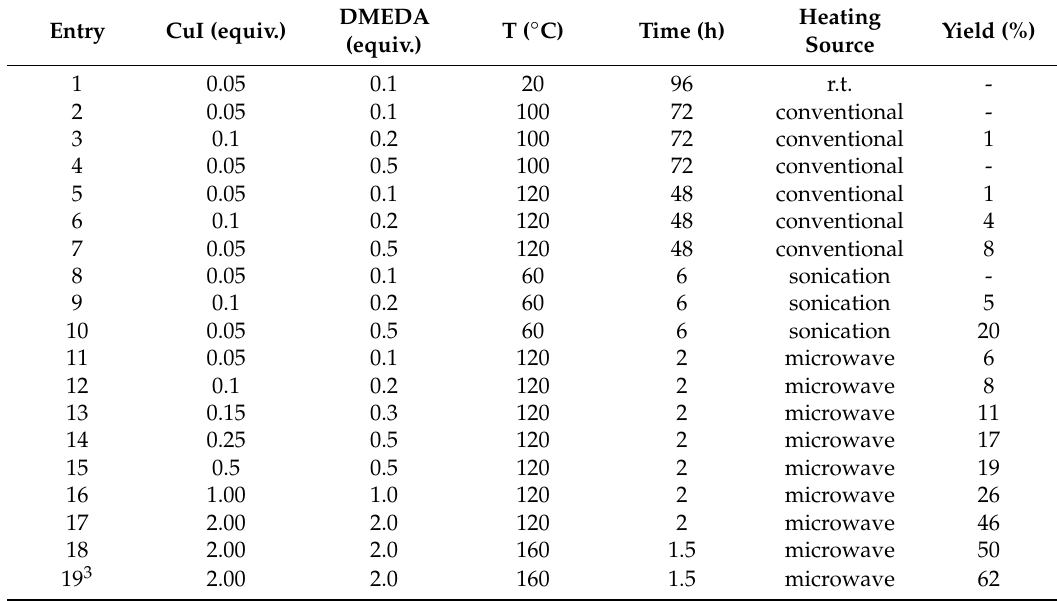
Table 2. Optimization of reaction conditions for the synthesis of compound 6 . 1,2. Scheme 1. General synthetic pathway for selected compounds. ( a ) N , N ’-dimethylethylenediamine